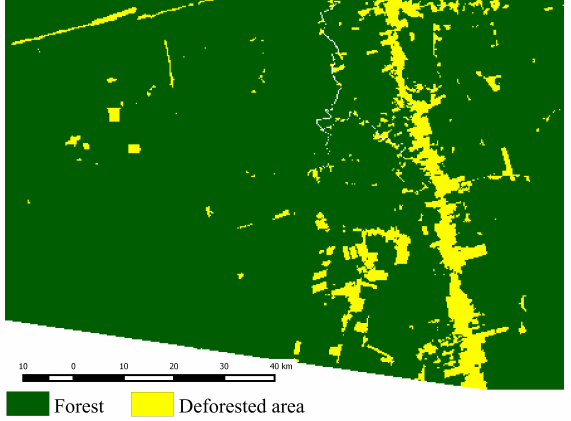
Figure 2: Land use / cover map